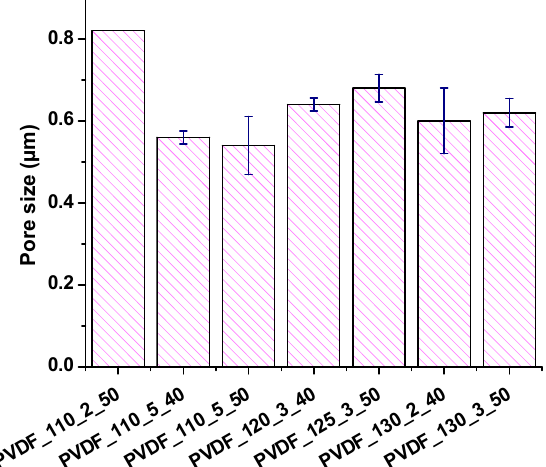
Figure 8. The average pore size of various nanofibrous membranes.